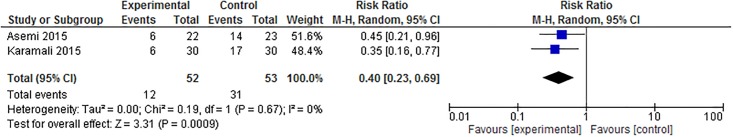
Meta-analysis of the frequency of hospitalized newborns.